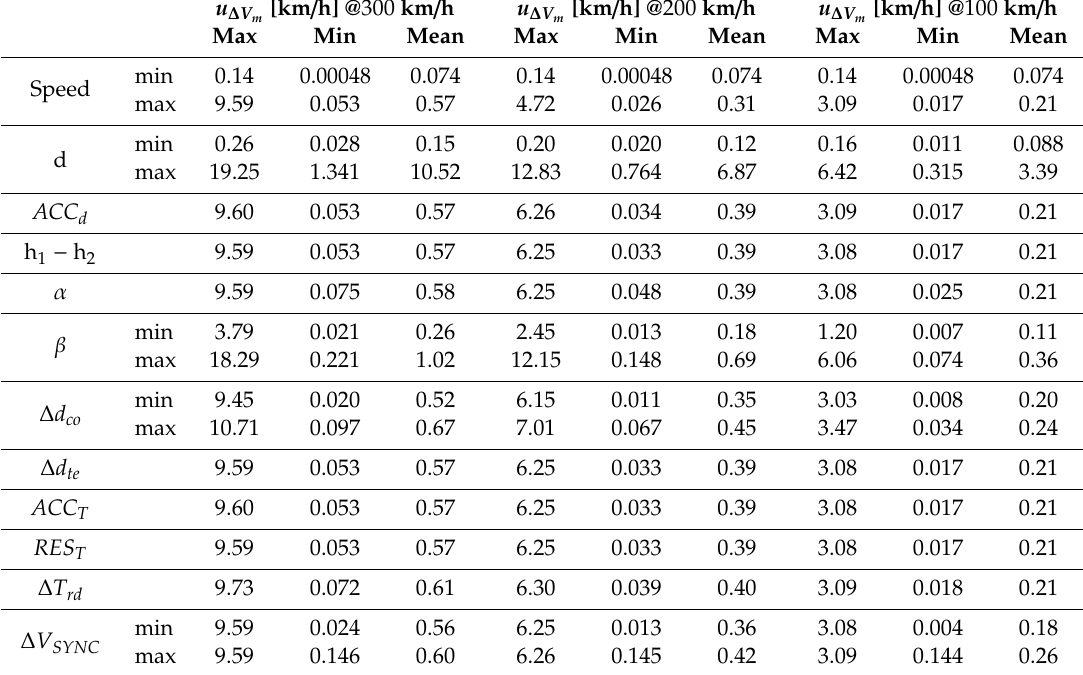
versus the different uncertainty parameters. m